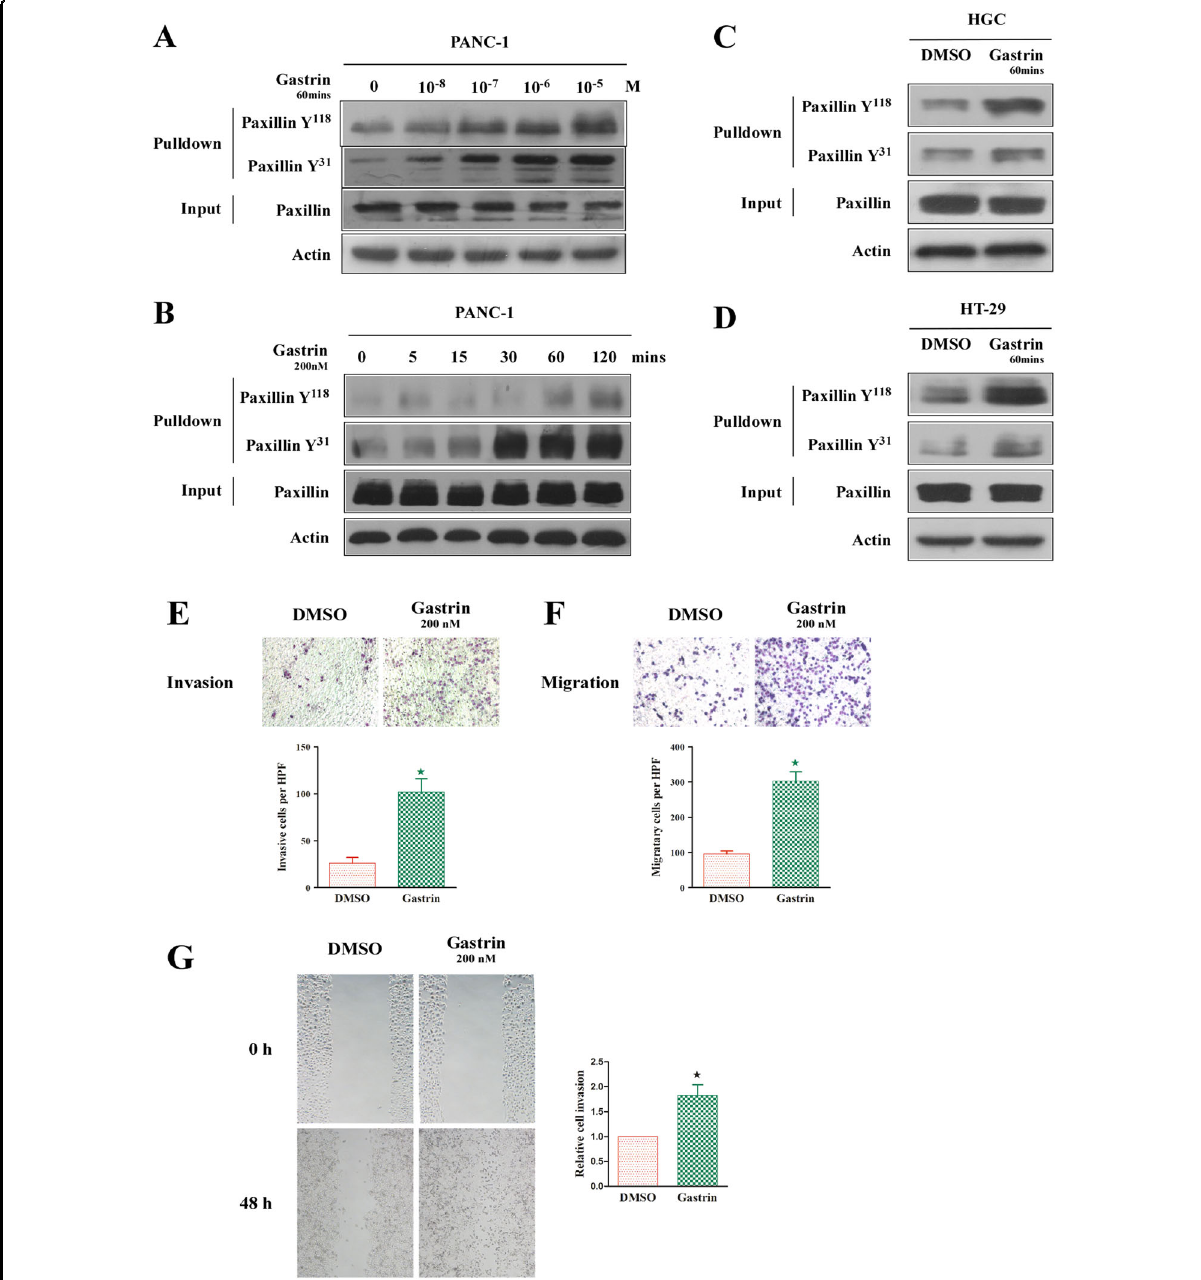
Fig. 1 Gastrin regulates paxillin activation and migration of pancreatic cancer cells. a Gastrin dose dependently induces elevated tyrosine phosphorylation of paxillin in PANC-1 cells. b Gastrin time dependently induces elevated tyrosine phosphorylation of paxillin in PANC-1 cells. c 200 nM gastrin treatment for 60 min can activate paxillin in HGC cells. d 200 nM gastrin treatment for 60 min can activate paxillin in HT-29 cells. e , f Gastrin (200 nM) promotes the invasion ( e ) and migration ( f ) of PANC-1 cells, as indicated by Boyden chamber assays. g The wound healing assay indicates the elevated migration of PANC-1 cells following 48 h of gastrin stimulation. β -actin was used as a loading control. The values indicate the means ± SD from three independent